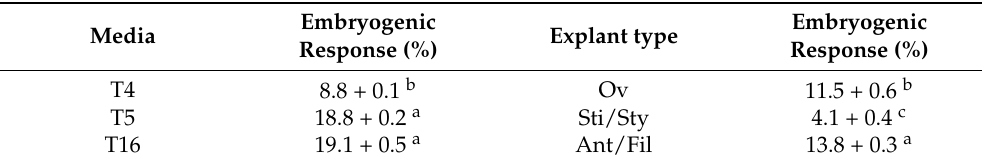
Table 4. Effect of three PGR combinations (T4, T5, T16) and three explant types (Ov, Sti/Sty, Ant/Fil) on embryogenic response. Data were collected 6 months after the beginning of the experiment. Means ± SE, in each column values followed by the same letter are not significantly different at p ≤ 0.05 level (Tukey’s test).